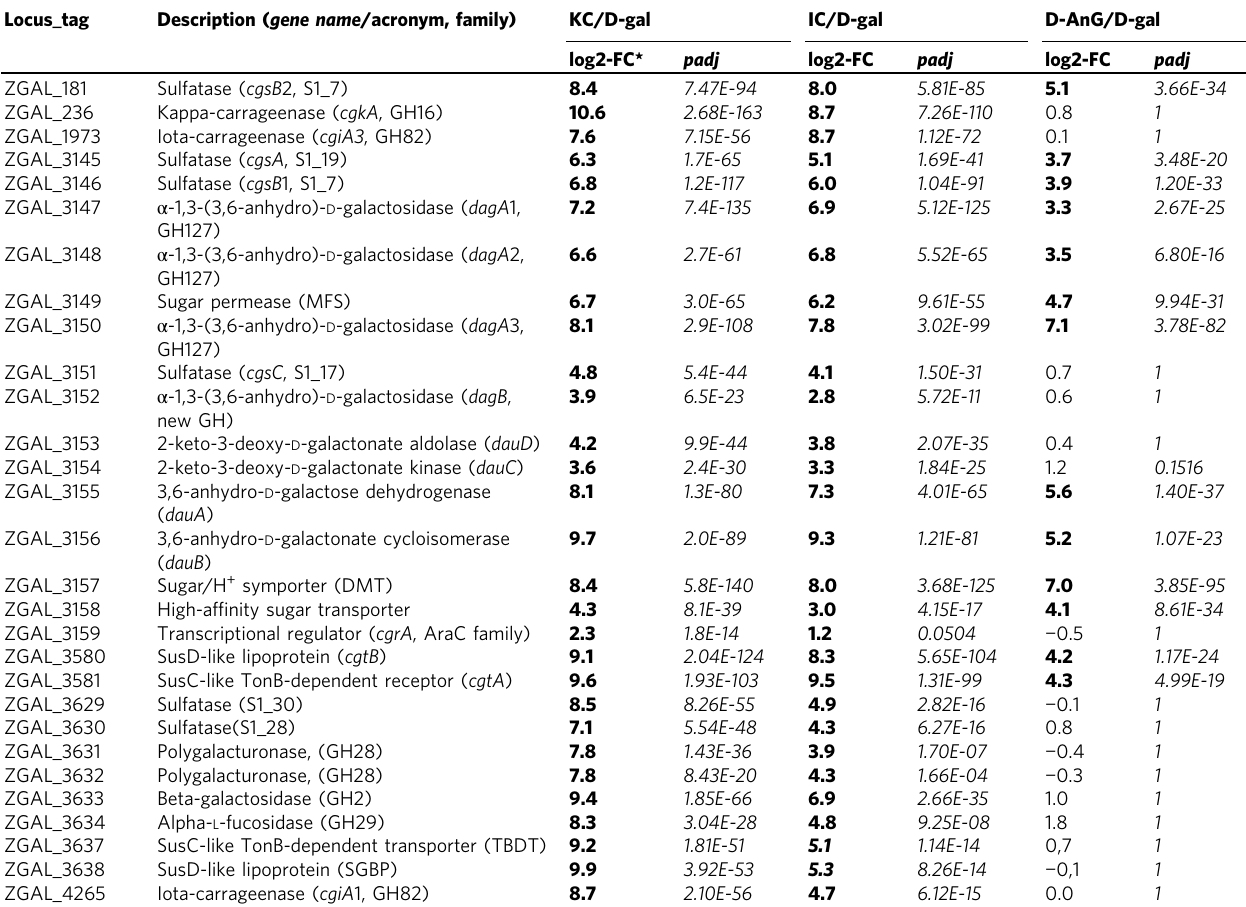
Table 1 Selection of carrageenan-induced genes in Z. galactanivorans Locus_tag Description ( gene name /acronym,